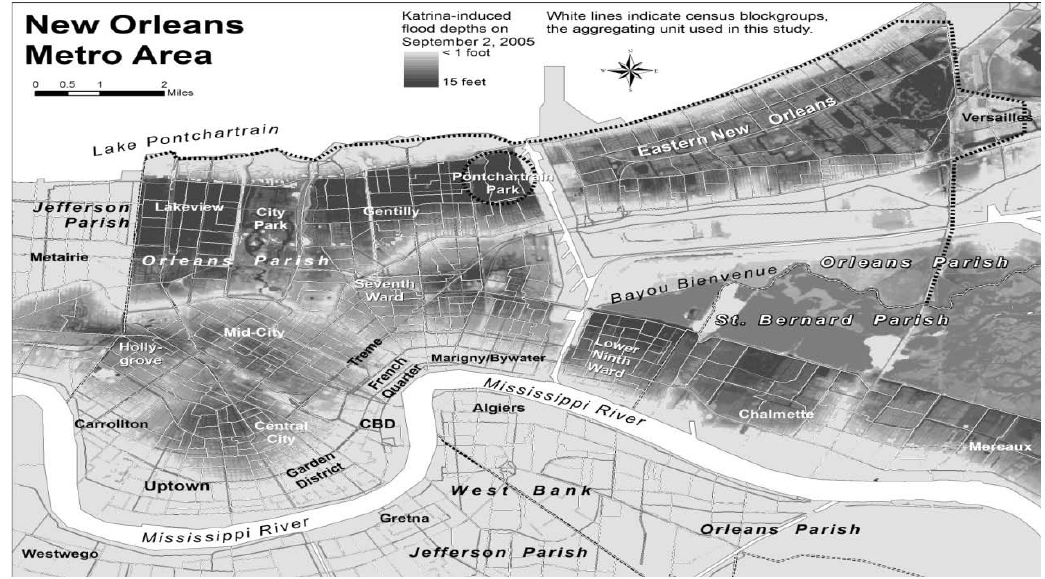
Figure 2. Map of New Orleans showing flood depth by census block